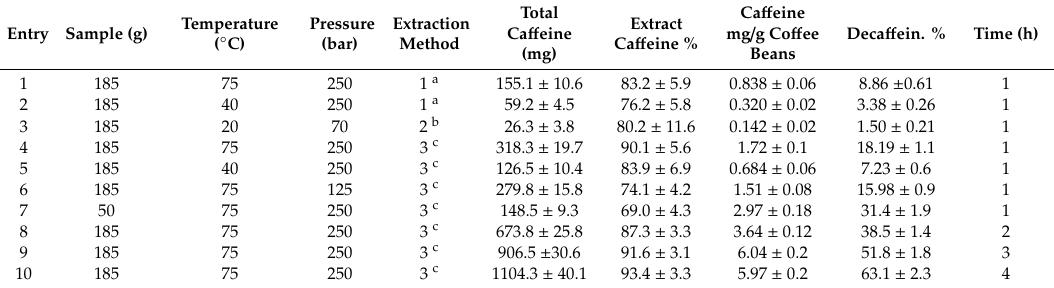
Table 1. Experimental conditions for ca ff eine extraction from Arabica green co ff ee beans and ca ff eine determination using UPLC-MS / MS analyses. Reported data are the mean of two